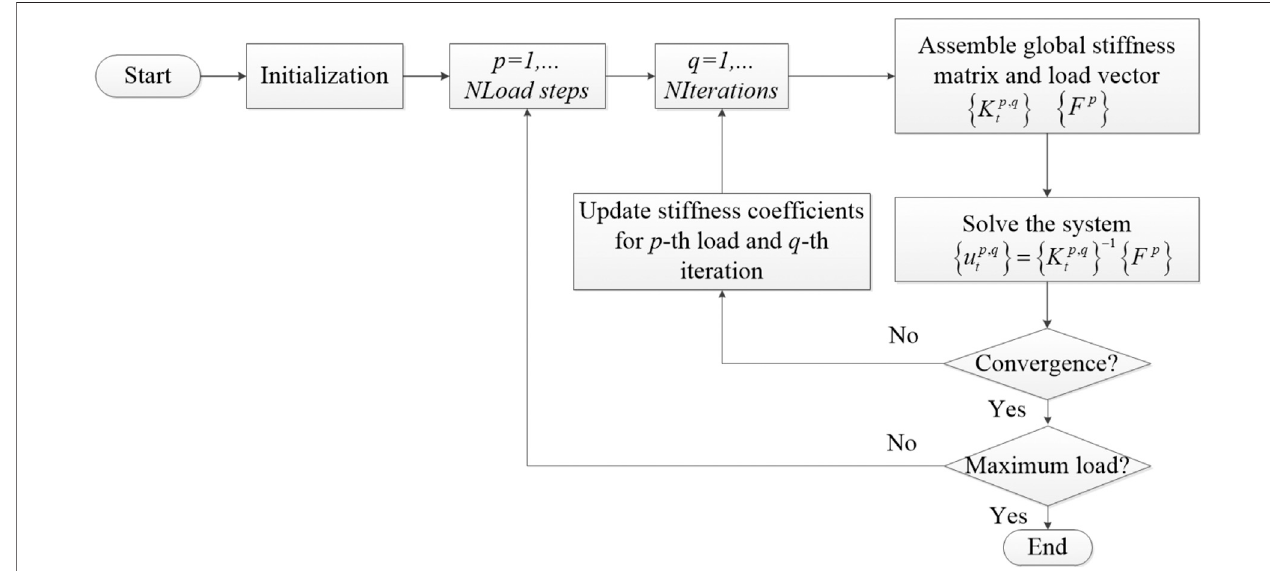
FIGURE 2 | Framework of proposed numerical strategy for static